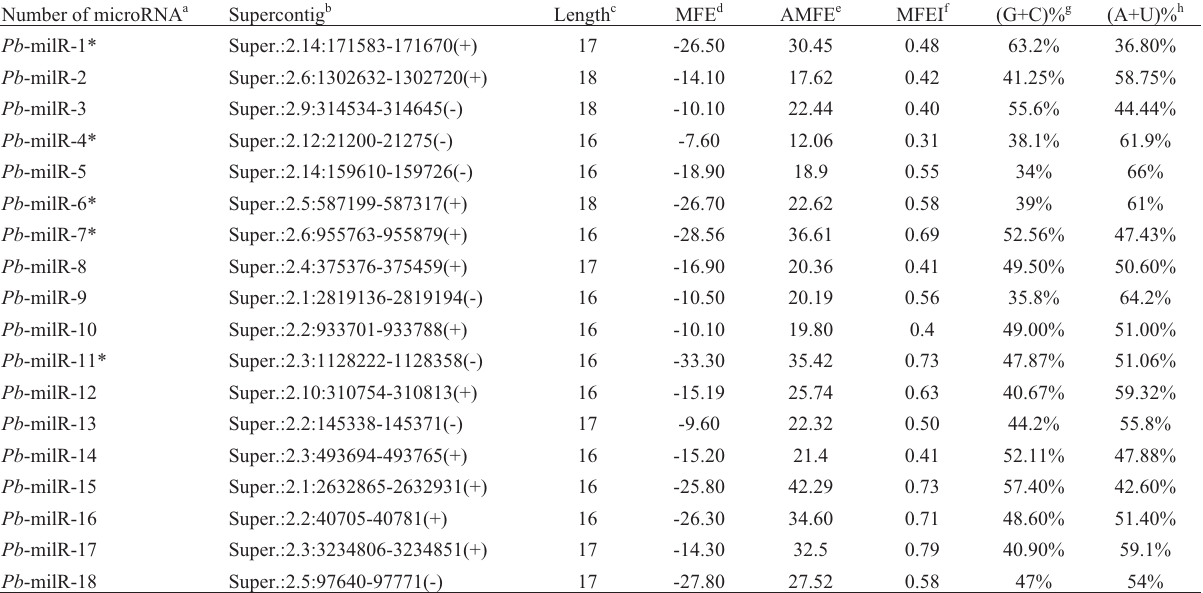
Table 3 - Characteristics of miRNAs-like molecules predicted in this study.